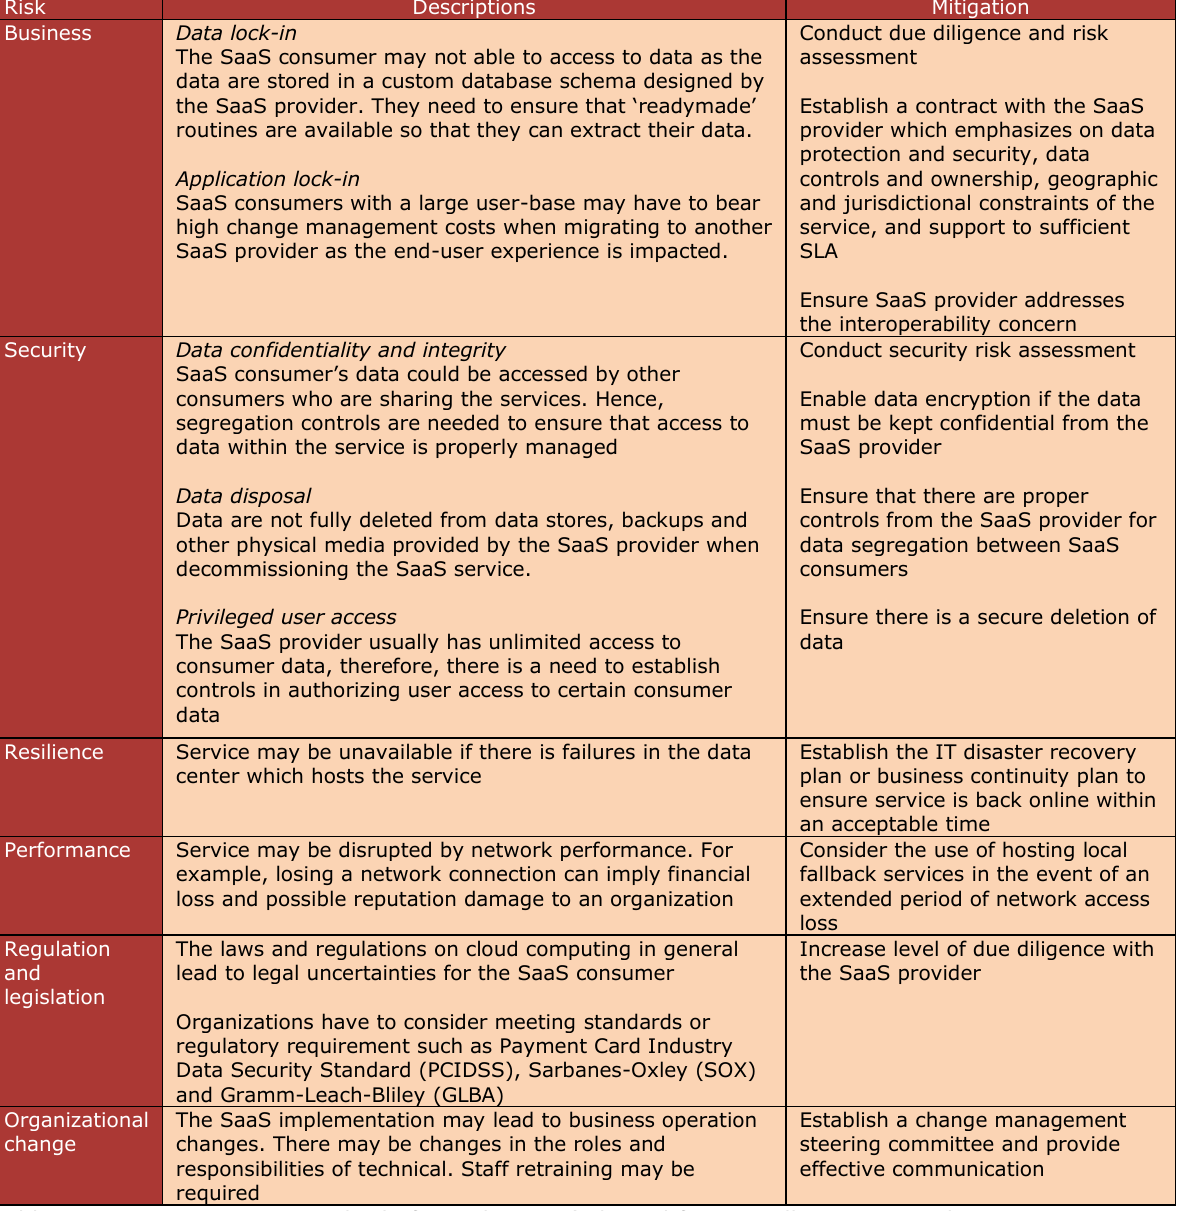
Table 2. SaaS aspects to consider before adoption (adapted from Brodkin, 2008; Deloitte, 2010;